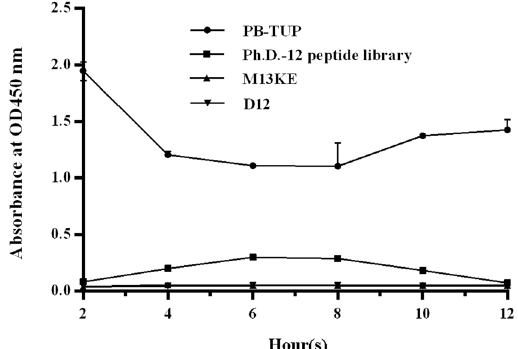
Figure 6. Effects of pH on phage binding to polystyrene. The binding ability of phages was analyzed under different pH conditions in ELISA. pH affected the polystyrene binding capacity of PB-TUP phage clone. Little difference was found for the other groups. Acidic and basic pH increased the binding ability of PB-TUP.